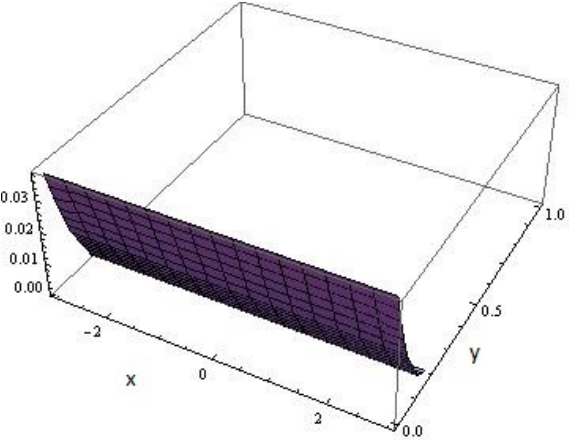
Figure 4. The capacity component F θθ of the free energy fluctuations as a function of the vacuum parameter x : = θ and temperature y : = T , describing fluctuations of the YM vacuum ensemble for a given anomaly factor c , decoherence temperature d , and critical exponent e